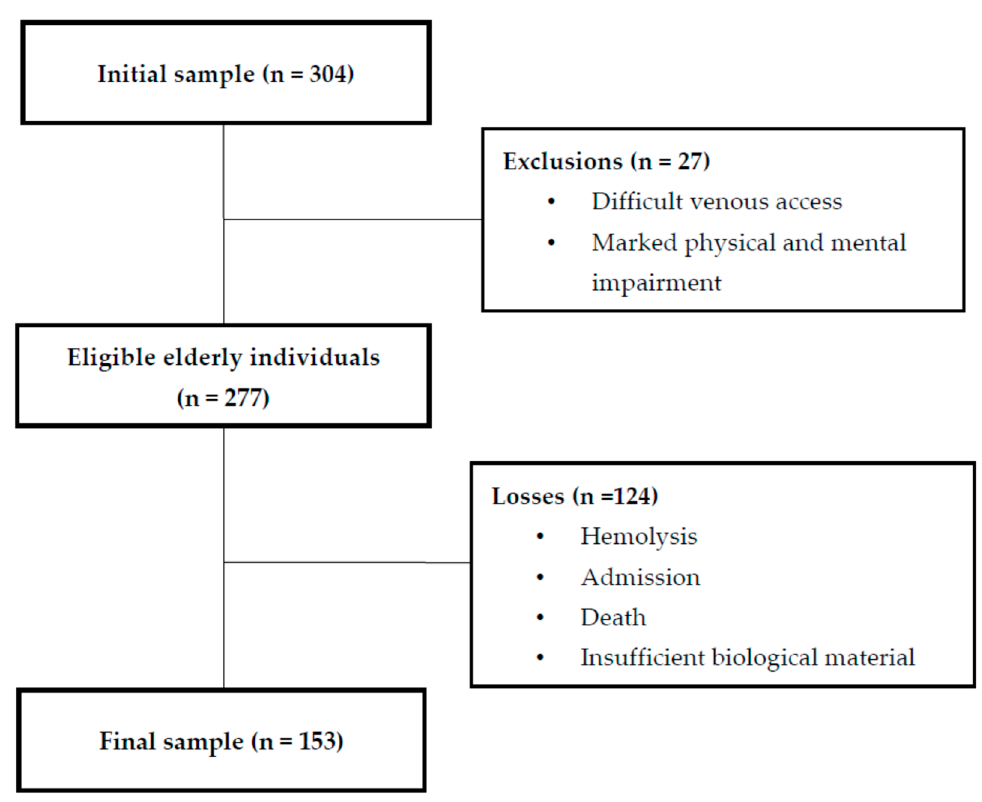
Figure 1. Flowchart of the study participants.